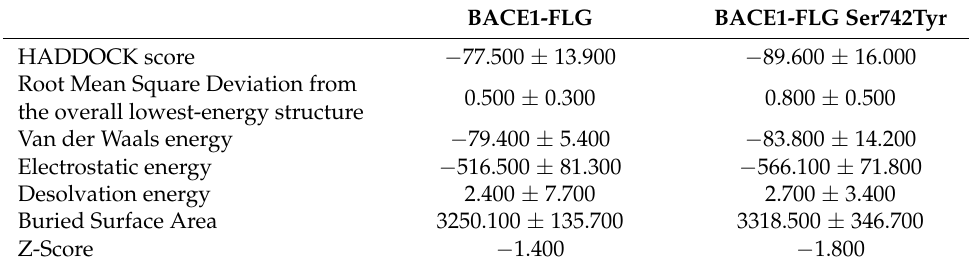
Table 3. Docking results of BACE1 interaction with selected proteins.